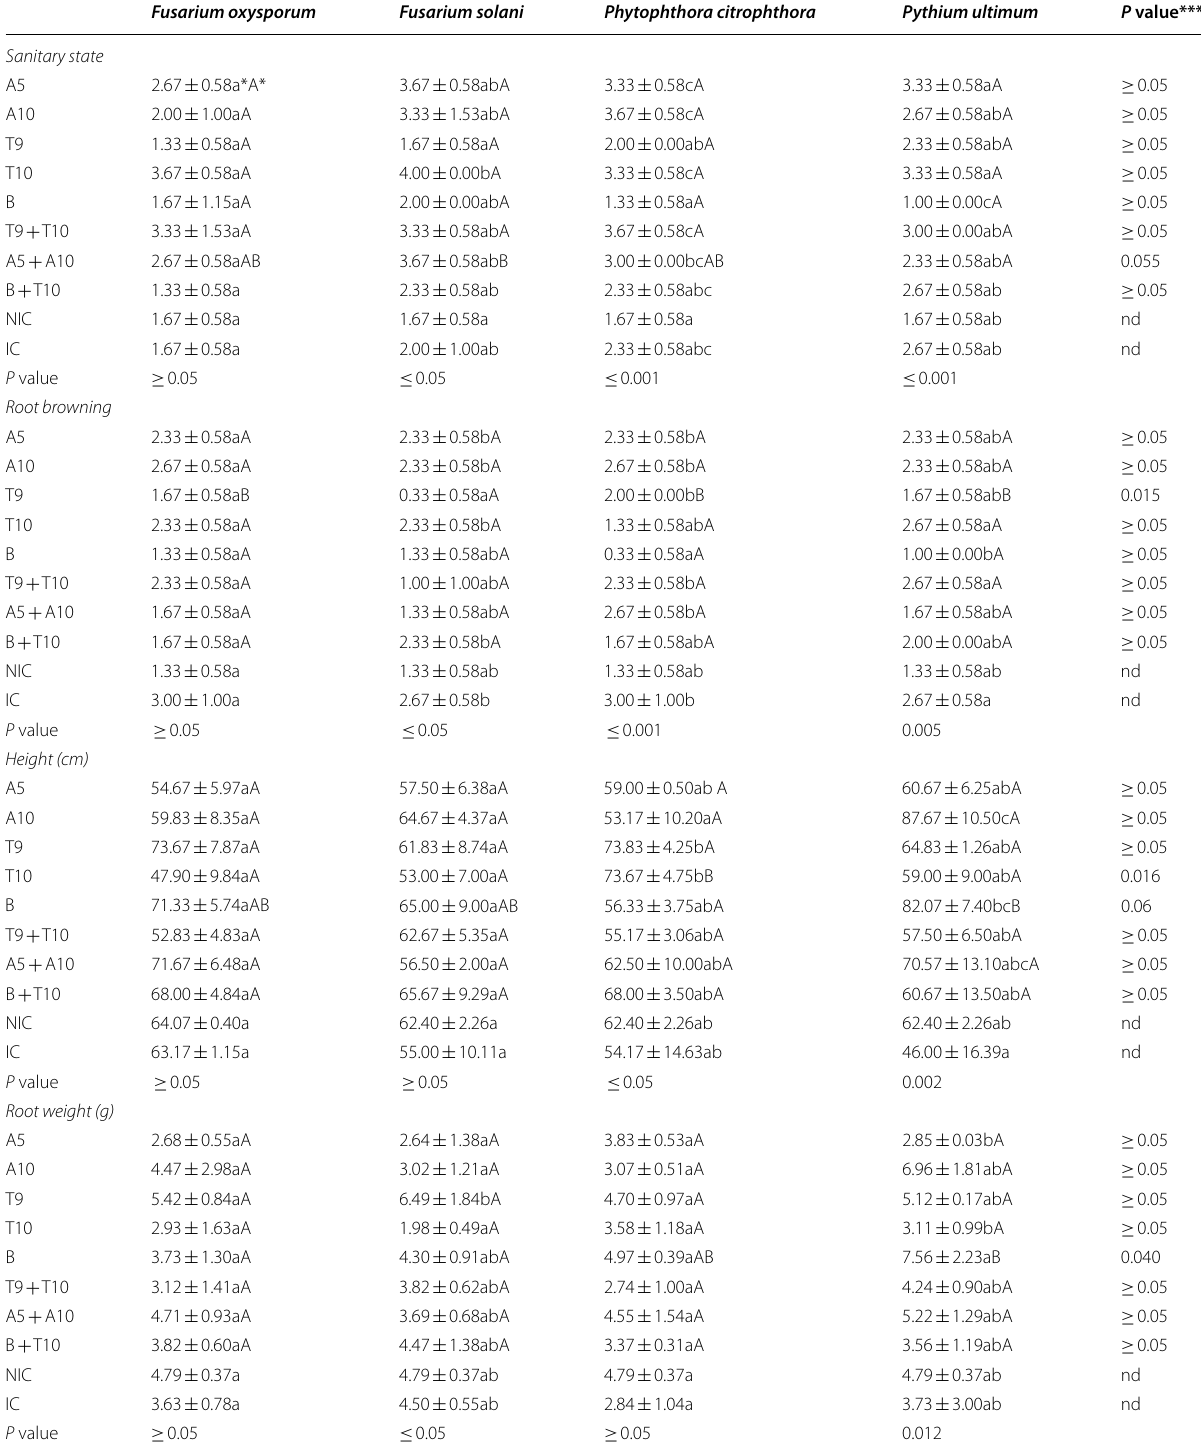
Table 5 Effect of two Trichoderma and Aspergillus species isolates and Bacillus subtilis on the severity of decline disease and seedlings growth three months after the inoculation on peach seedlings